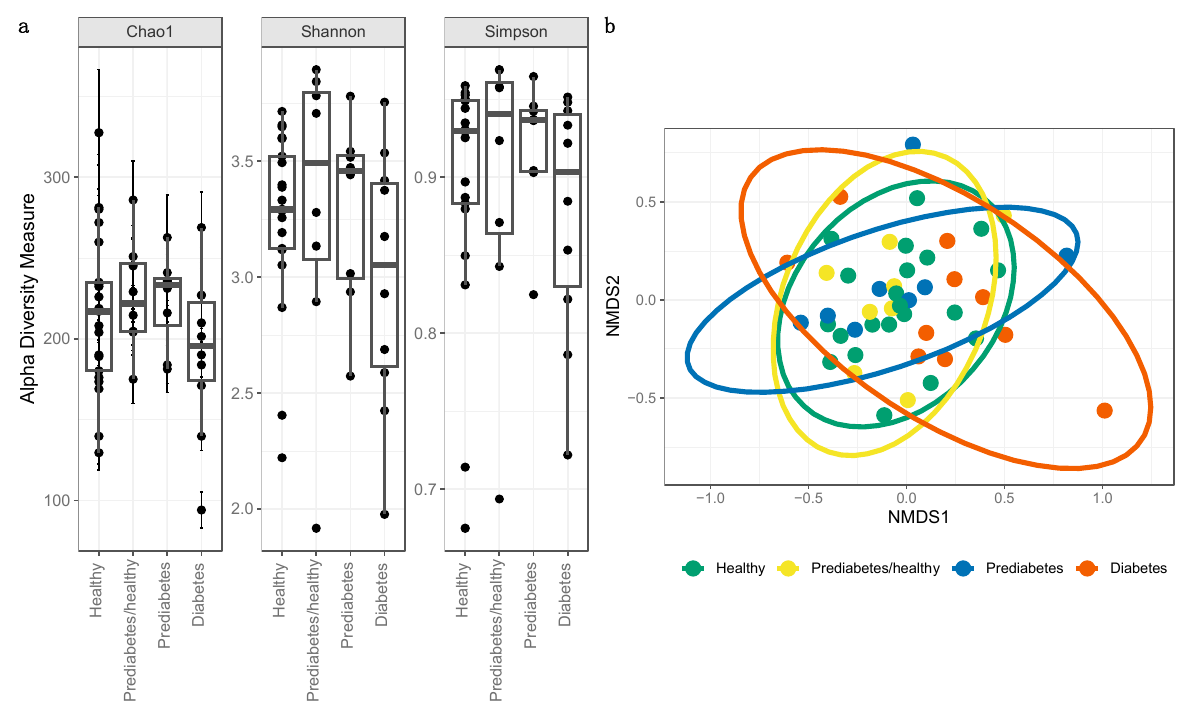
Figure 2. ( a ) Microbial alpha diversity as measured by the Chao1, Shannon, and Simpson index of fecal samples, which are colored according to four health status categories. All alpha diversity metrics were not statistically different between health status categories. ( b ) Microbial beta diversity. Dimensional reduction of the Bray-Curtis distance between microbiome samples, using NMDS ordination method, for fecal samples in healthy and controls. Data points are colored according to healthy